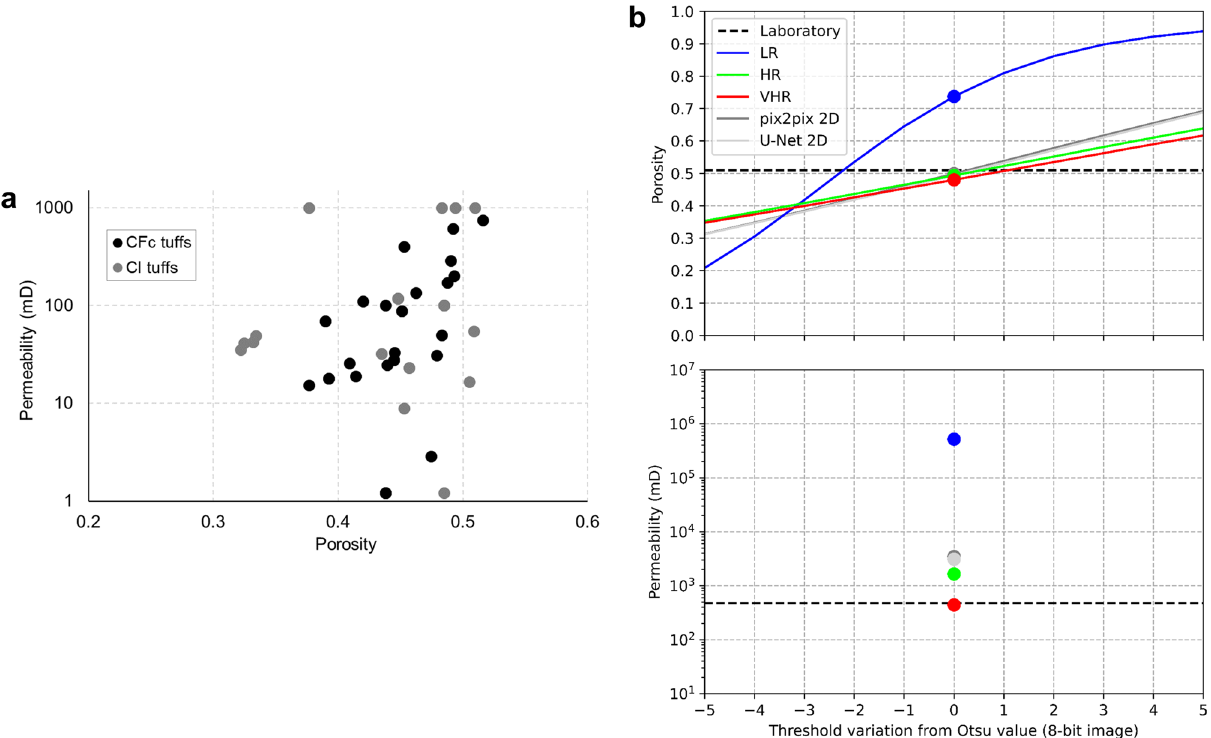
Figure 2. Petrophysical properties of Campi Flegrei tuffs and investigated Campanian Ignimbrite tuff. ( a ) Literature data on Campi Flegrei caldera (CFc) tuffs using conventional laboratory approaches 57–60 . Data on Campanian Ignimbrite (CI) tuff are shown in grey. CI tuff can be classified as a highly porous and moderately permeable material, whose hydraulic properties are strongly depending on composition, high pumice content and degree of welding of ignimbritic deposit. The other tuffs mainly originated during Neapolitan Yellow Tuff, Gauro, La Pietra, Nisida and Baia eruptions. ( b ) Porosity (top) and permeability (bottom) estimated through digital rock physics analyses of LR, HR and VHR images (central 640 3 px) as well as of super-resolved images (all 2560 3 px: 640 3 px × scaling factor of 4, for total porosity; central 900 3 px for intrinsic permeability, the maximum volume exploitable for our computational system, see also Fig. 6), obtained applying the best trained models (2D U-Net and pix2pix) to the LR image. The effect of threshold variations (i.e., threshold sensitivity) is also shown, estimating the total porosity as the threshold value diverges from an optimal value (i.e., Otsu value; 0 in x axis and circle symbol). Laboratory data are provided for